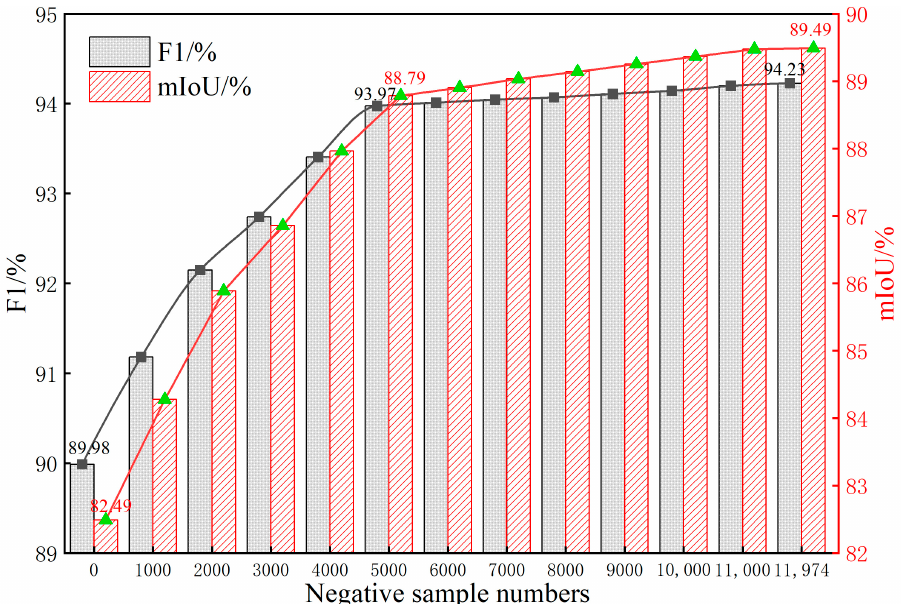
Figure 11. E ff ects of di ff erent numbers of negative samples on the distress segmentation Figure 11. Effects of different numbers of negative samples on the distress segmentation performance. performance.